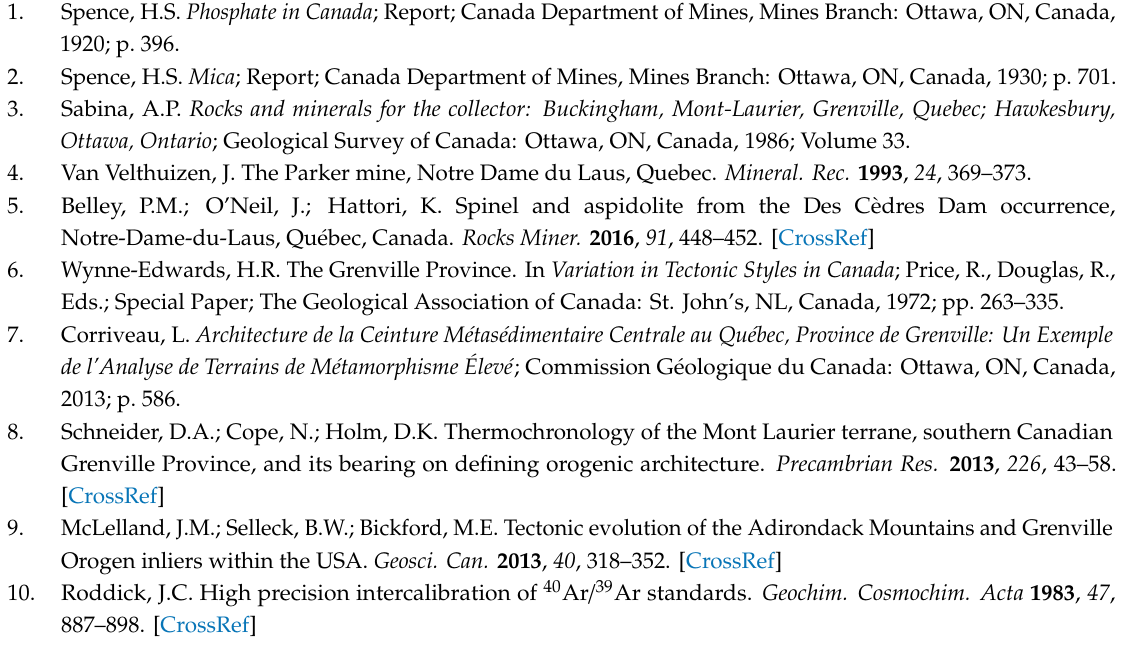
Figure S1: Large-area transmitted-light microscopy mosaic of the dunite thin section “Parker Mine 5”; Figure S2: Argon / argon age spectrum; Figure S3: Atlas 5 large-area SEM image mosaic of the large spinel crystal (Parker Mine 10b); Figure S4: EDS point analyses 1 to 12.; Figure S5: EDS point analyses 13 to 24.; Table S1: Excel spreadsheet of the acquired isotopic data from phlogopite crystal D-648.; Table S2: Excel spreadsheet of the acquired isotopic data from phlogopite crystal